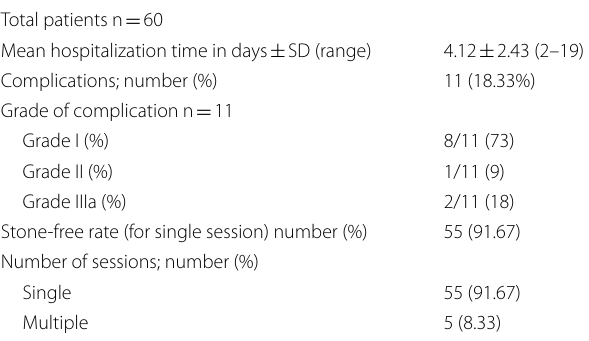
Table 1 Baseline patients characteristics